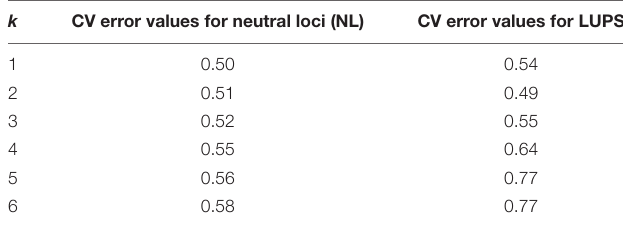
TABLE 4 | Cross-validation error values for successive k of 1–6 on